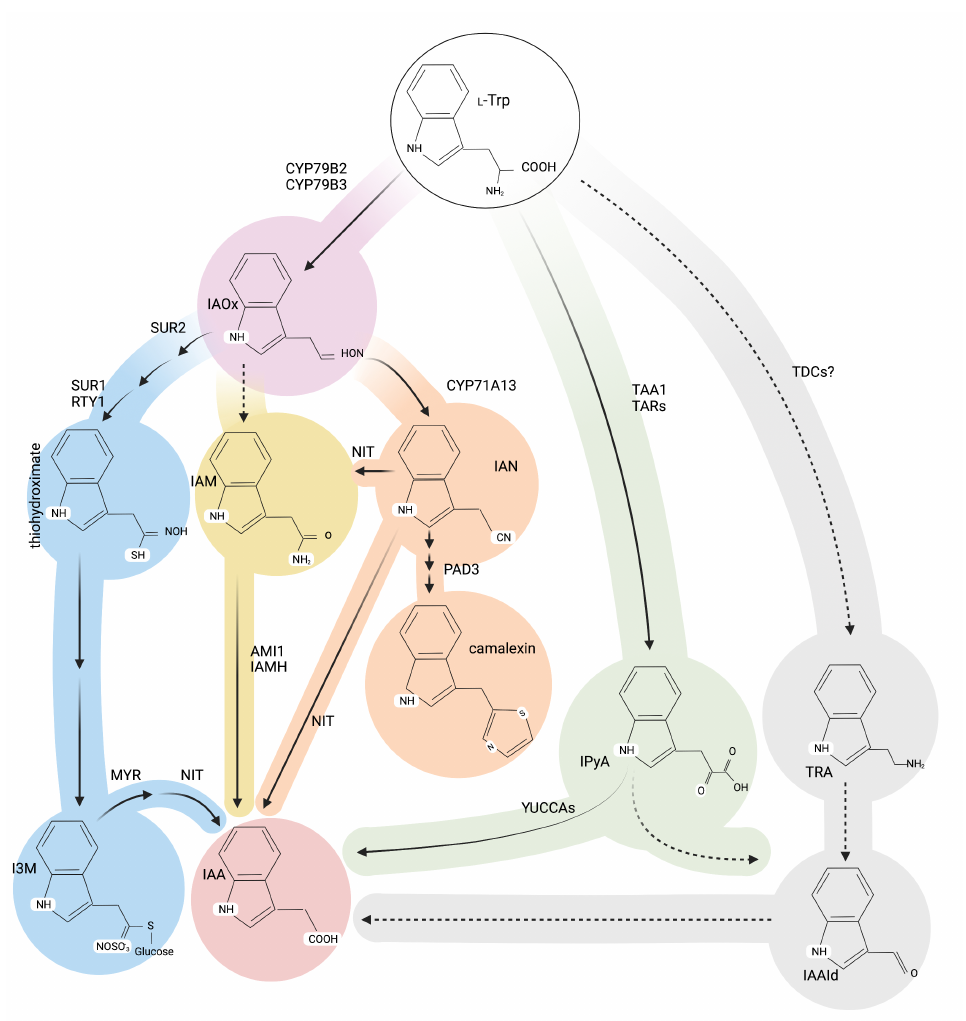
Figure 2. Abbreviated representation of L -Trp derived anabolic pathways for indole glucosinolate, camalexin, and indole-3-acetic acid biosynthesis in Arabidopsis. The reaction steps catalyzed by so far unidentified genes/enzymes are represented by dashed lines. Each postulated L -Trp derived shunts are coloured as follow: thiohydroximate in blue, IAM in yellow, IAN in orange, IPyA in green, TRA in grey. AMI1, AMIDASE1; CYP71A13, CYTOCHROME P450 MONOOXYGENASE 71A13, CYP79B2, CYTOCHROME P450 MONOOXYGENASE 79B2, CYP79B3, CYTOCHROME P450 MONOOXYGENASE 79B3, I3M, glucobrassicin; IAA, indole-3-acetic acid; IAAld, indole-3- acetaldehyde; IAM, indole-3-acetamide; IAMH, IAM HYDROLASE1-2, IAN, indole-3-acetonitrile; IAOx, indole-3-acetaldoxime; L-Trp, L-tryptophan; MYR, MYROSINASE; NIT, NITRILASE1-3; PAD3, PHYTOALEXIN DEFICIENT3 (CYP71B15); RTY, ROOTY; SUR1, SUPERROOT1; SUR2, SUPER- ROOT2 (CYP83B1),TAA1, TRYPTOPHAN AMINOTRANSFERASE OF ARABIDOPSIS 1; TAR,